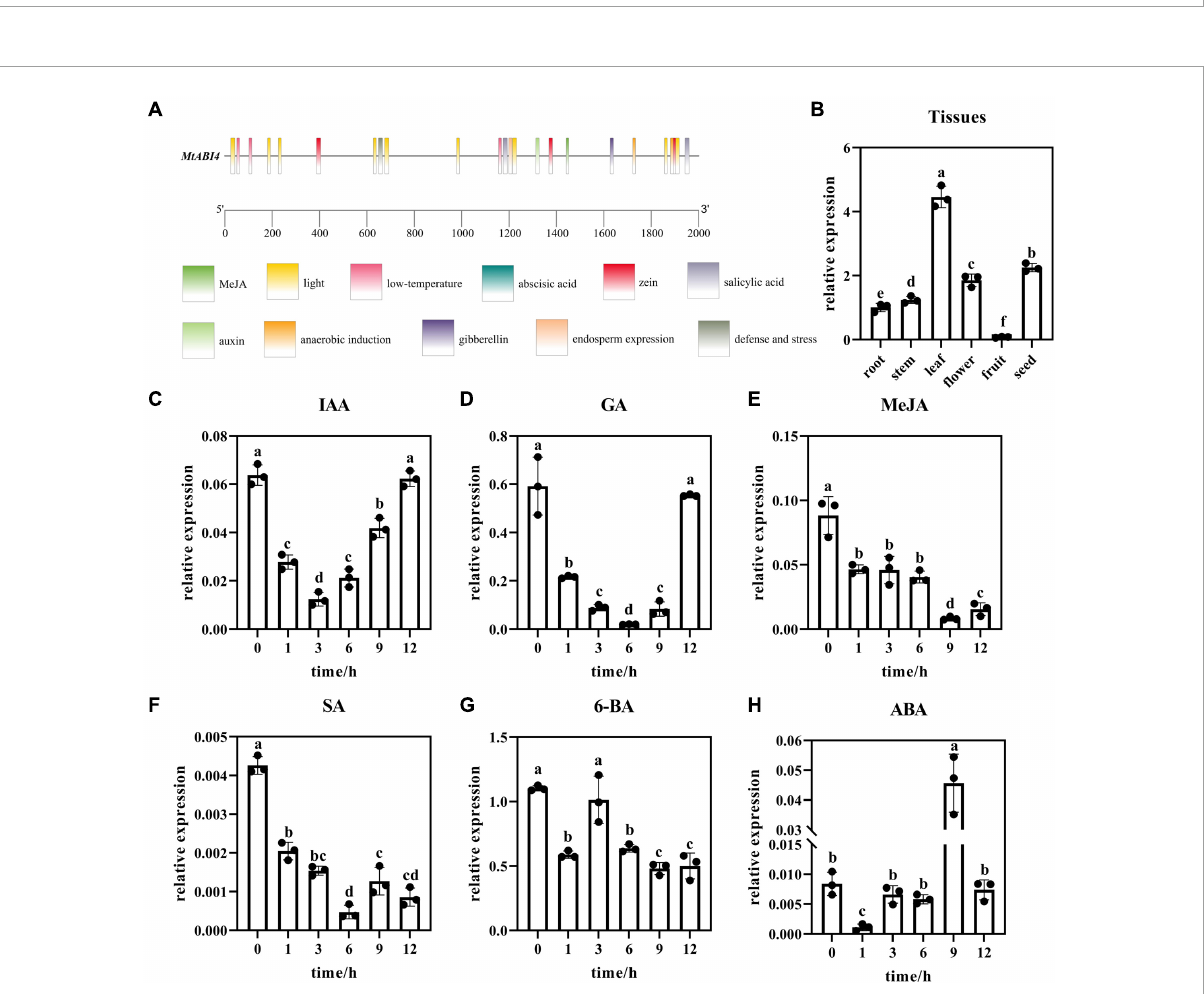
FIGURE2 Cis-acting elements analysis and the expression patterns of MtABI4 by qRT-PCR analysis. In graph panel (A) , different color blocks represent different cis-acting elements. The scale bar represents the length of the base sequence. Panel (B) represents the expression of ABI4 in different tissues. Different letters in graphs indicate significant differences at p ≤ 0.05. Panels (C–H) represents the expression of ABI4 at different time points in response to IAA, GA, MeJA, SA, 6-BA, and ABA, respectively. The values are means ± SD ( n =